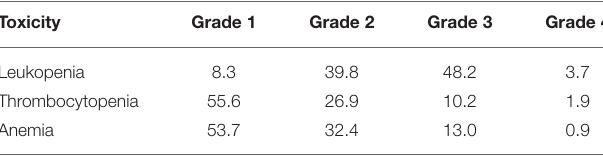
TABLE 4 | Incidence of treatment-related acute hematologic toxicity (%).